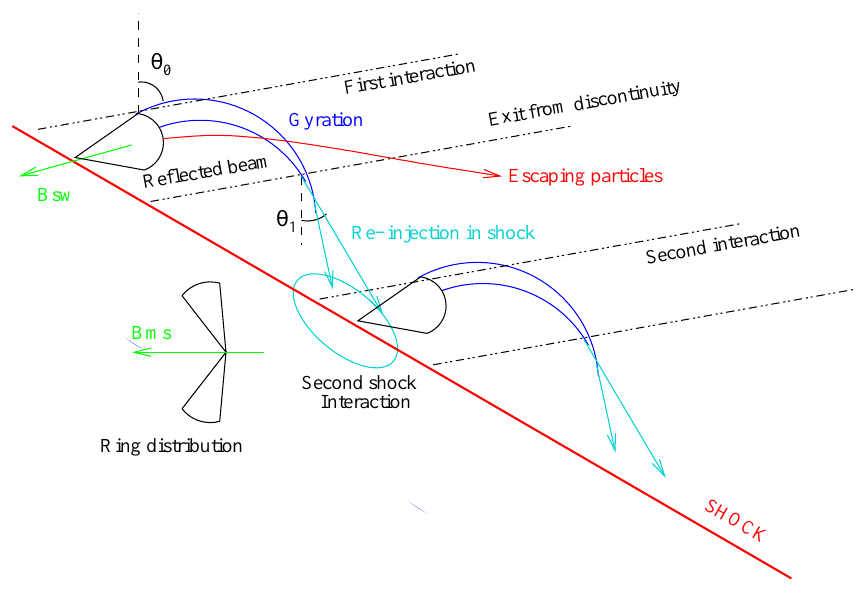
Fig. 8. A sketch of the Fermi acceleration of the reflected ion beam at quasi-perpendicular shock.